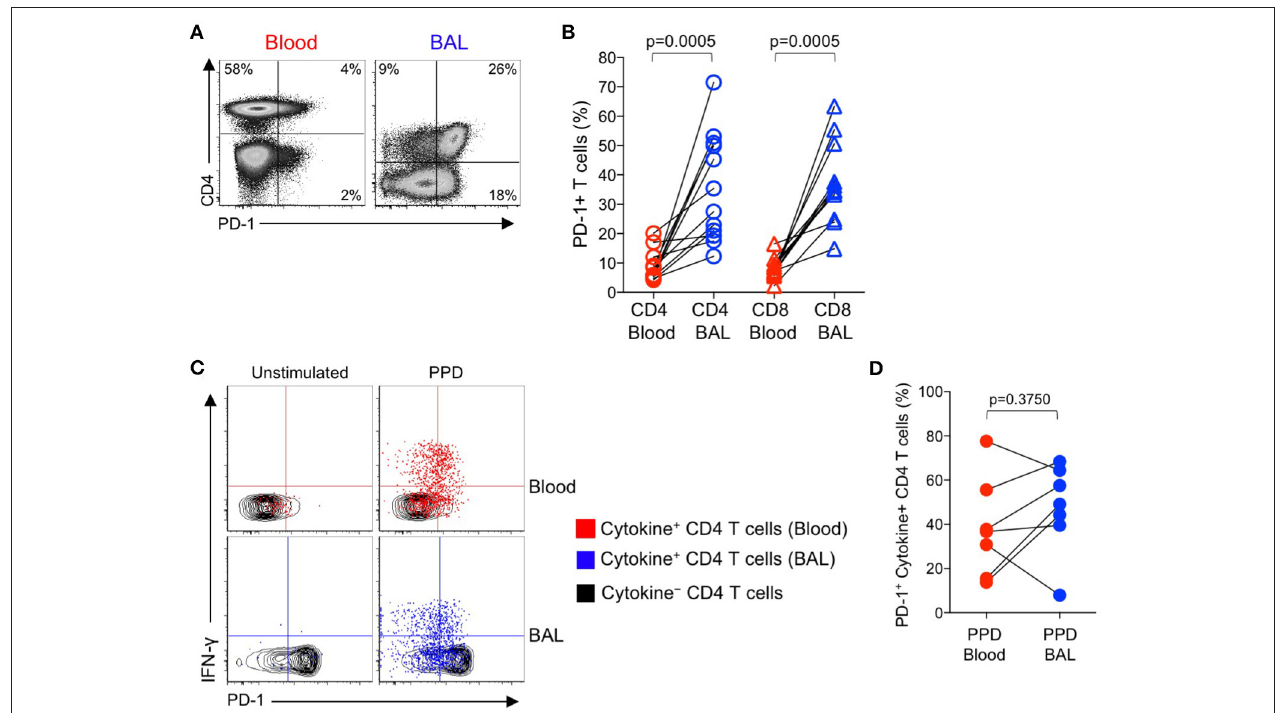
FIGURE 4 | PD-1 expression by PPD-specific CD4T cells is similar in the lung and peripheral blood of individuals with LTBI. Bronchoalveolar lavage (BAL) was performed on individuals with LTBI ( n = 12); blood samples collected just prior to the BAL procedure. Whole blood and cells isolated from BAL fluid were stimulated in parallel with PPD for 6h. PD-1 expression was measured on cytokine + (IFN- γ , TNF- α , and/or IL-2) PPD-specific and total CD4 and CD8T cells in blood and BAL by flow cytometry. (A) Flow cytometry data of PD-1 expression by T cells from paired blood and BAL samples from a single individual with LTBI. Plots are shown gated on viable CD3 + T lymphocytes. (B) Comparison of PD-1 expression on the total CD4 and CD8T cell populations in paired blood and BAL samples from individuals with LTBI. (C) Flow cytometry data indicating PD-1 expression by cytokine + , PPD-specific CD4T cells from paired blood and BAL samples from two individuals with LTBI. Plots are shown gated on viable CD3 + CD4 + lymphocytes. Cells in gray indicate cytokine − CD4T cells (for both blood and BAL samples); cells in red indicate PPD-specific CD4T cells in the blood producing any combination of IFN- γ , TNF- α , and IL-2; cells in blue indicate PPD-specific CD4T cells in BAL producing any combination of IFN- γ , TNF- α , and IL-2. (D) Comparison of PD-1 expression by PPD-specific CD4T cells producing any combination of IFN- γ , TNF- α , and IL-2 in paired blood and BAL samples from individuals with LTBI ( n = 7). Differences in (B, D) were assessed using the Wilcoxon matched pairs signed rank